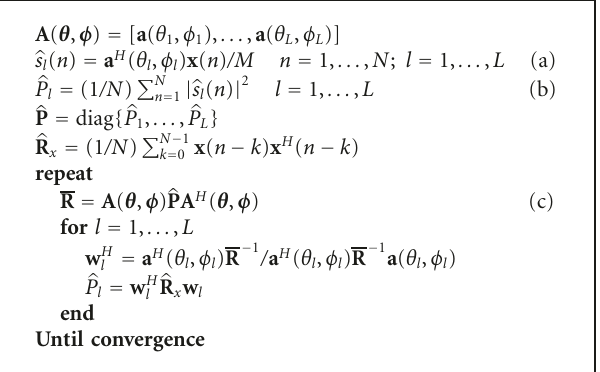
Algorithm 1: IAA algorithm